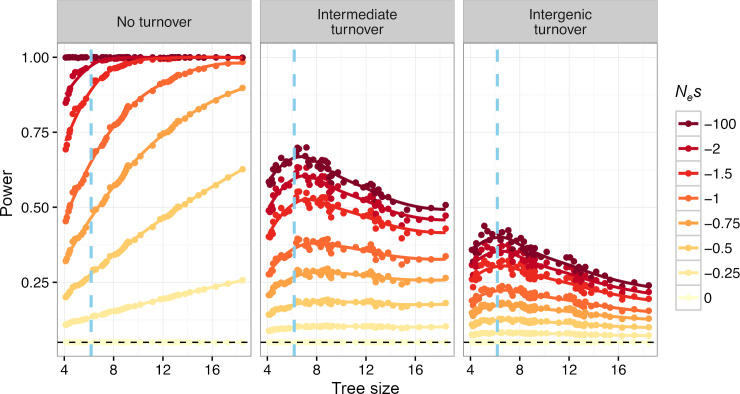
Power to detect purifying selection using GERP scores as a function of tree size.Colored lines denote different strengths of purifying selection. Tree size is defined as the sum of lengths of all branches of the tree. Branch length is measured as expected neutral substitutions, i.e. a branch with length one has on average one neutral substitution. The tree size is varied by including/excluding species from a phylogenetic tree of 100 vertebrates (see main text). Left panel shows no turnover. Right panel shows intergenic levels of turnover with turnover rate as estimated in Rands et al. [25] for noncoding elements. Middle panel shows intermediate turnover with a rate half of that in the right panel. Blue vertical lines denote the tree size of the 36 mammalian species tree that is commonly used for calculation of GERP. See S2 Text for further discussion of alternate strategies for adding species.